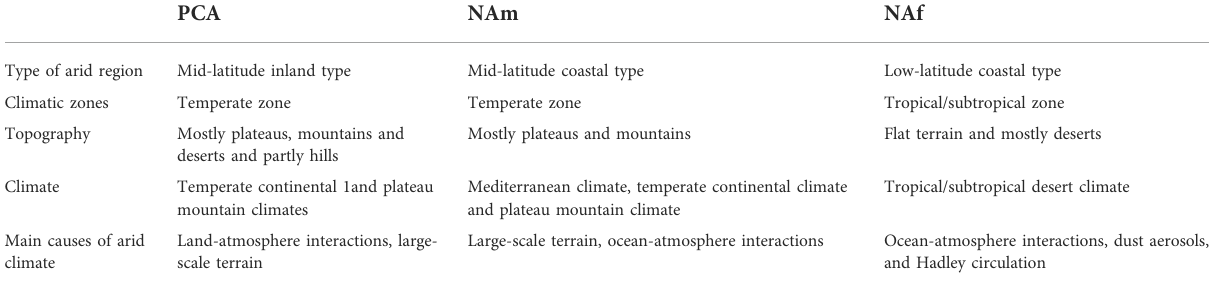
TABLE 1 Typical arid regions in the Northern